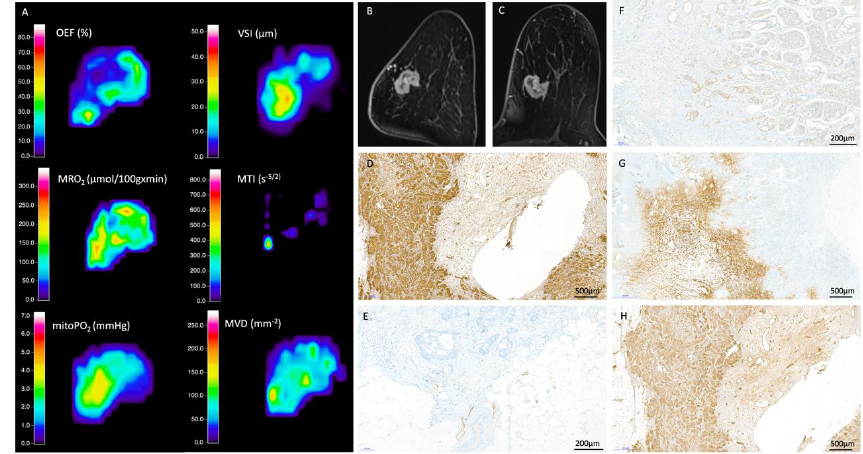
Figure 2. Radiologic-histopathologic correlation: 83-year-old patient with an invasive ductal carcinoma (ER / PR − , HER2 − , ki-67 30%). ( A ) MRI biomarkers ( B ) CE-T1 image coronal ( C ) CE-T1 image axial ( D ) FLT 1 ( E ) Podoplanin ( F ) HIF-1alpha ( G ) CA IX ( H ) VEGF-C. CE-T1 displays a